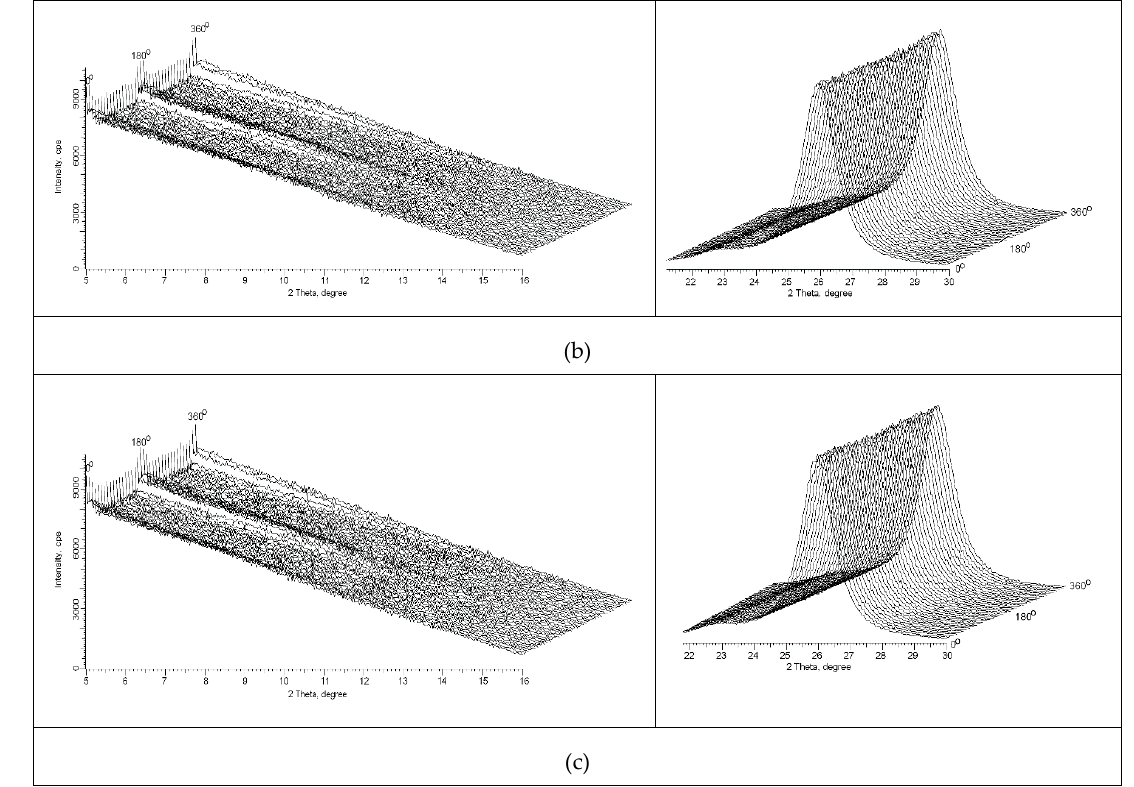
Figure 5. X-ray diffraction patterns of test samples polymer films: ( a ) irradiated Kr 13+ ions; ( b ) Figure 5. X-ray di ff raction patterns of test samples polymer films: ( a ) irradiated Kr 13 + ions; ( b ) irradiated irradiated Kr 14+ ions; ( c ) irradiated Kr 15+ ions. Kr 14 + ions; ( c ) irradiated Kr 15 +